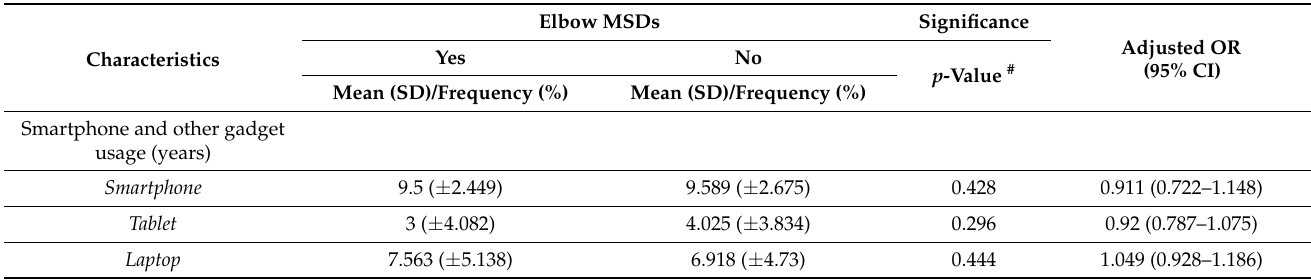
Table 6. Association between elbow MSDs and smartphone